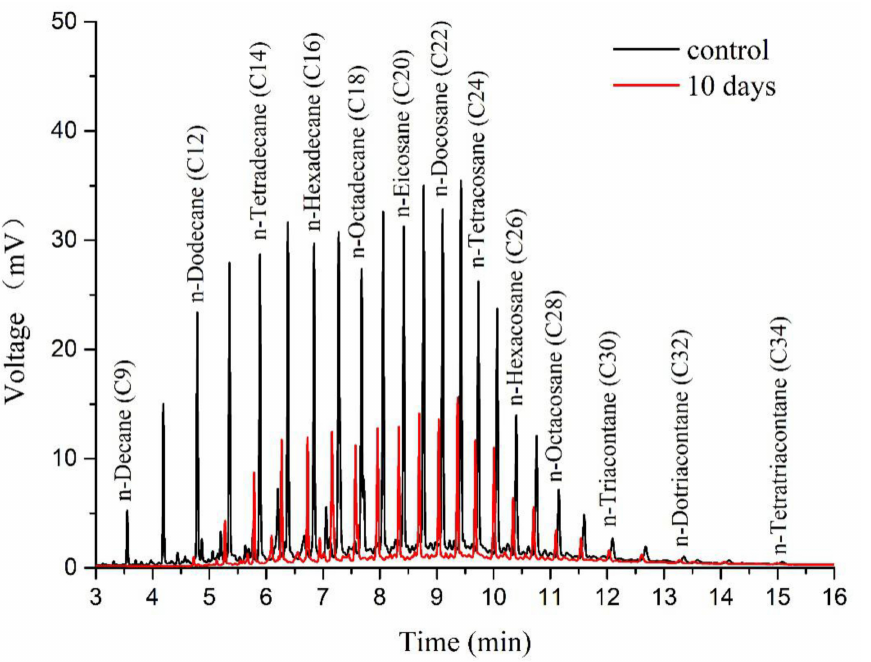
Figure 2. The comparison of GC profiles of TPH removal by Acinetobacter sp.: a control group and 10 days.